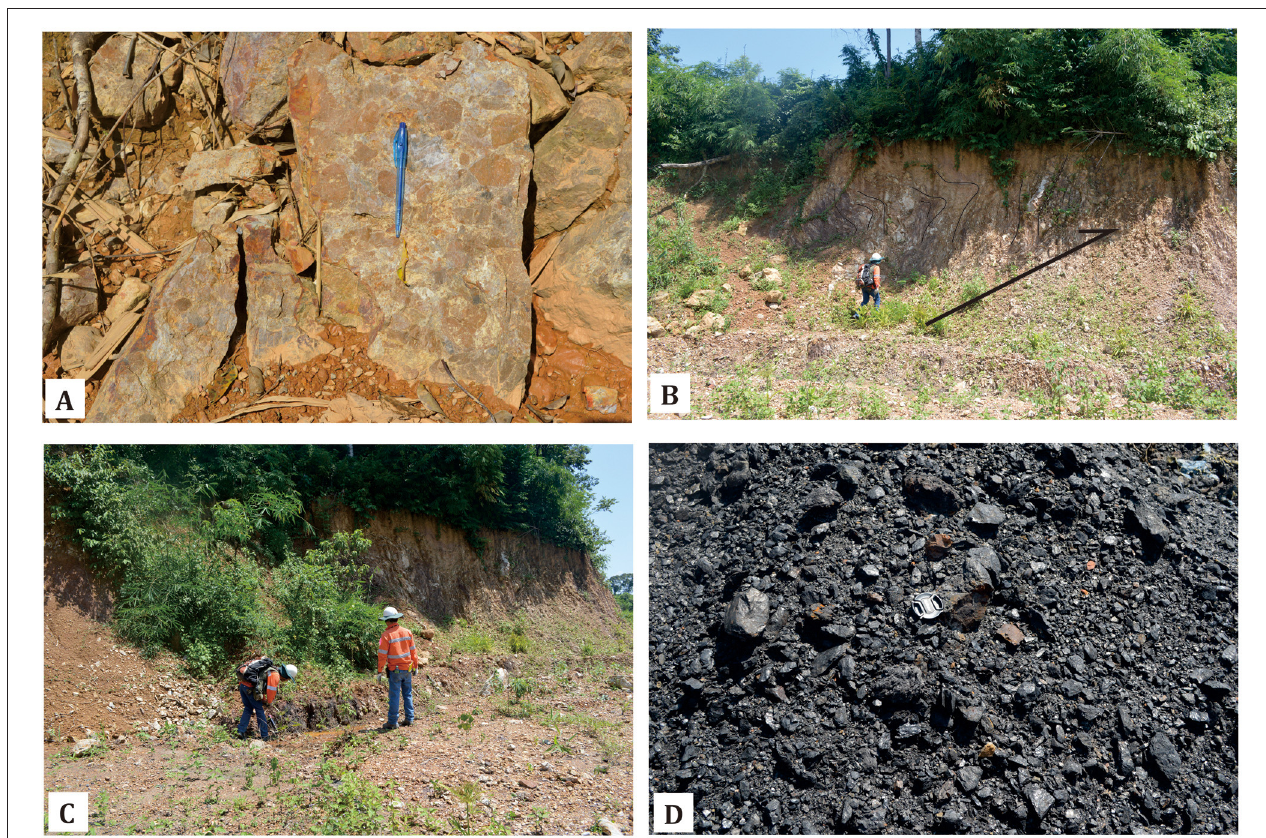
FIGURE 11 | Field photograph of Unit D of probable Boualapha Formation correlate 20km south of the Sepon Mine but north of Tamky Suture (see Figure 1 for location). This unit consists mainly of a folded siliciclastic sequence, but the main competent units dip at 40 0 N. The lithofacies of this unit suggests a fluvial environment which overlies Unit C. Unit D consists of siltstones, quartz arenites, pebbly arkosic sandstone, quartzites, and conglomerates. (A) Conglomerates, (B) Folded fine siliciclastics with coal seam and plant remains. Vergence of the fold is to the south, (C) Unit D with coal seam, (D) Close-up of anthracitic